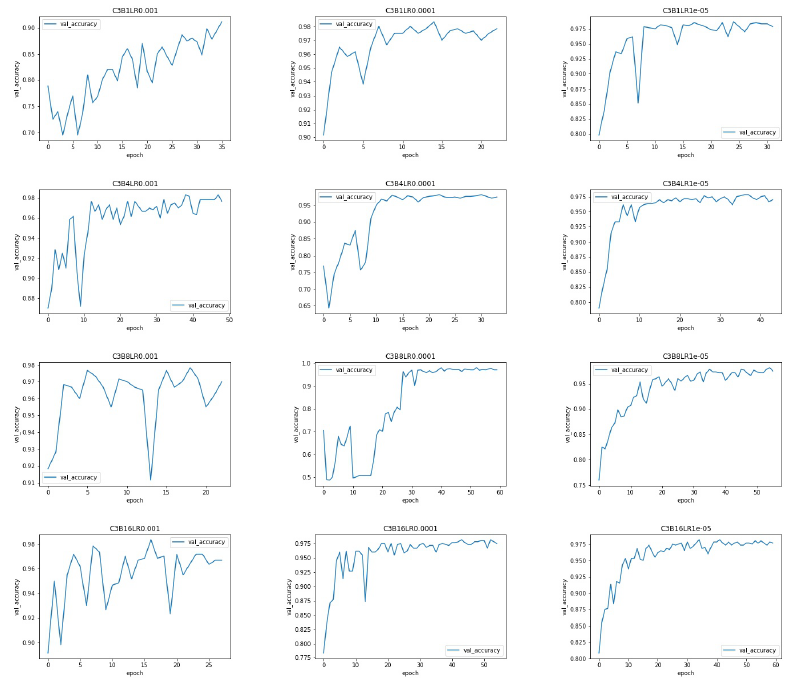
Figure 6. Three convolution block with different batch number and learning